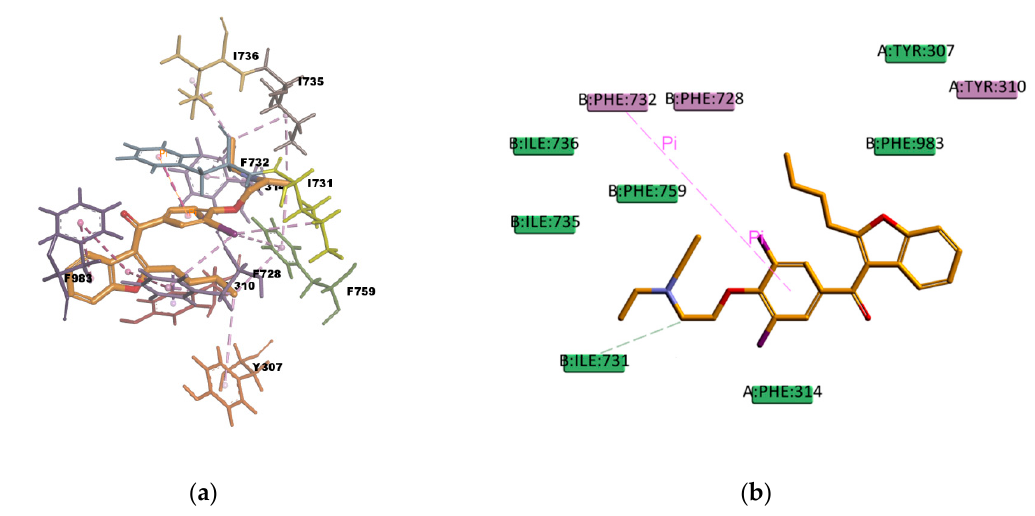
Figure 14. Amiodarone (AM) top-ranked pose obtained with CDOCKER algorithm. ( a ) 3D view of AM interactions in the binding pocket. Light-green dotted lines represent carbon hydrogen bond interactions, light-rose dotted lines represent hydrophobic interactions, and the pink dotted line represents a π – π stacking interaction. Residue I731 involved in a carbon hydrogen bond interaction is highlighted in yellow; ( b ) 2D interaction diagram of AM with h P-gp interacting residues. The light-green dotted line represents a conventional hydrogen bond interaction. The pink dotted line represents a π – π stacking interaction with residue F732.